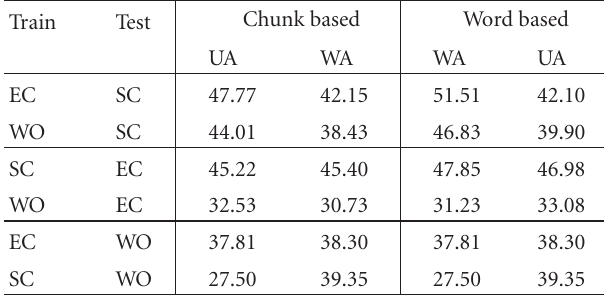
Table 8: Cross unit: train / = test; evaluation in percent correct; (un-)weighted average recall (UA/WA); acoustics only.